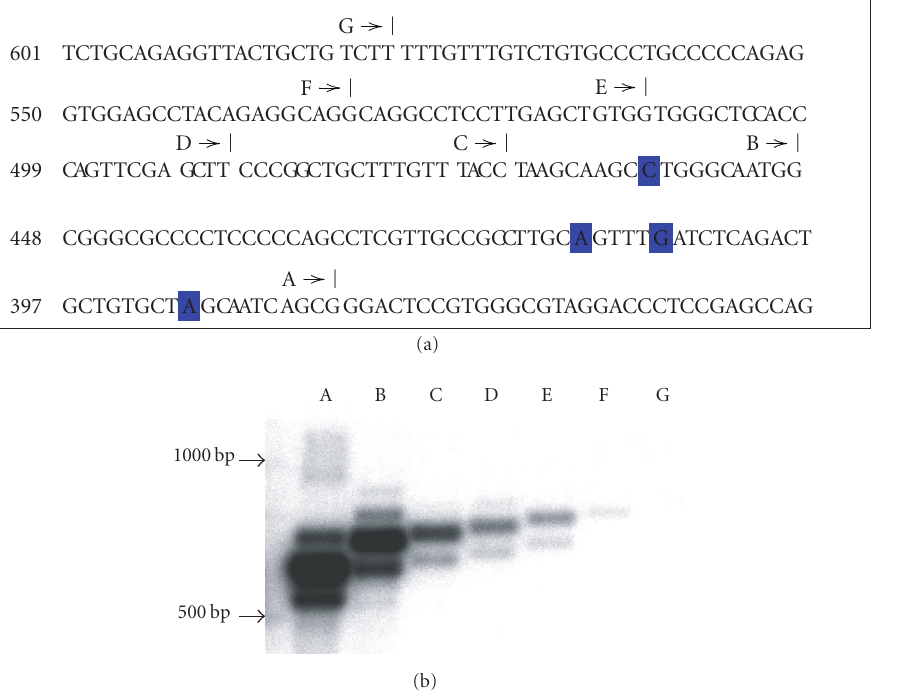
Figure 4: TSS mapped to the L1 ASP region. (a) The position of TSS present in the DBTSS is shown highlighted on the consensus sequence of L1Hs [4] between positions 347 and 601. TSS with single and multiple entries present in the database are represented by yellow and blue highlight, respectively. The letters above the sequence mark the 3 (cid:2) end of the oligonucleotide primers used in RT-PCR (see Table 1). (b) Southern blot RT-PCR analysis of the L1- MET transcripts. The lanes are marked according to the primers used in the PCR. Multiple bands on each lane represented the di ff erent splice variants of the L1- MET transcript, as confirmed by sequence analysis.